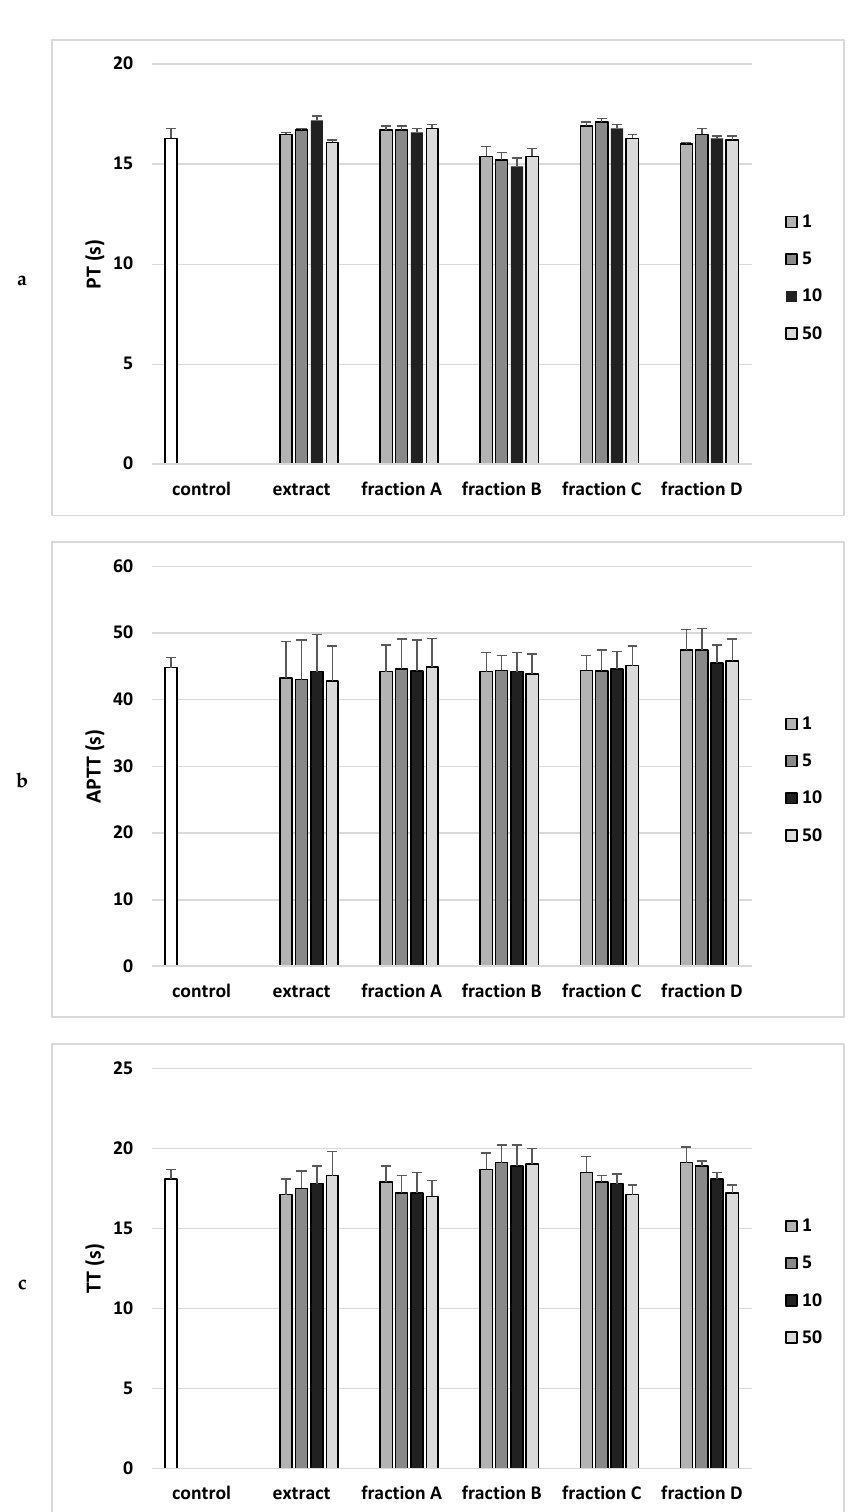
Figure 5. E ff ects of the extract and the four fractions (A–D, concentration range 1–50 µ g / mL, incubation time—30 min) from Paulownia Clone in Vitro 112 leaves on the hemostatic parameters: ( a ) prothrombin time (PT), ( b ) activated partial thromboplastin time (APTT), and ( c ) thrombin time (TT) of human plasma. Data are expressed as mean ± SEM ( n = 6). One-way ANOVA followed by a multicomparison Duncan’s test: p > 0.05, compared with